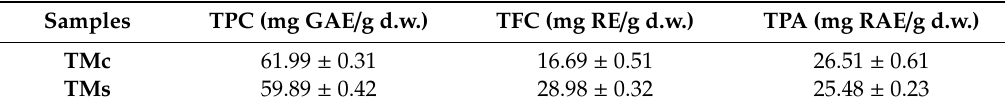
Note: Each value represents the mean ± standard deviations of three independent measurements. GAE: Gallic acid equivalents; RE: Rutin equivalents, RAE: Rosmarinic acid equivalents. Values represent the mean ± standard deviations, SD ( n =